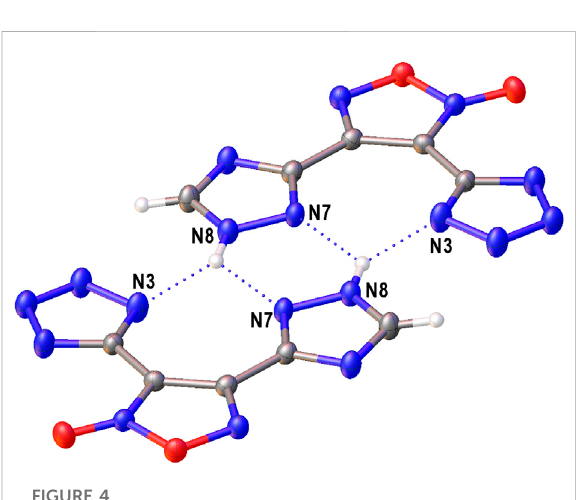
FIGURE 6 A fragment of crystal packing of 6 demonstrating the aggregation of in fi nite